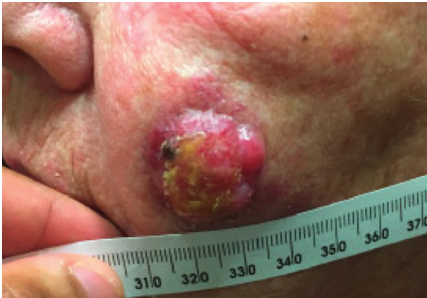
Figure 4: Primary site of disease to the left cheek (27 × 22mm) at the time of presentation to our multidisciplinary clinic (7.5 weeks after confirmatory